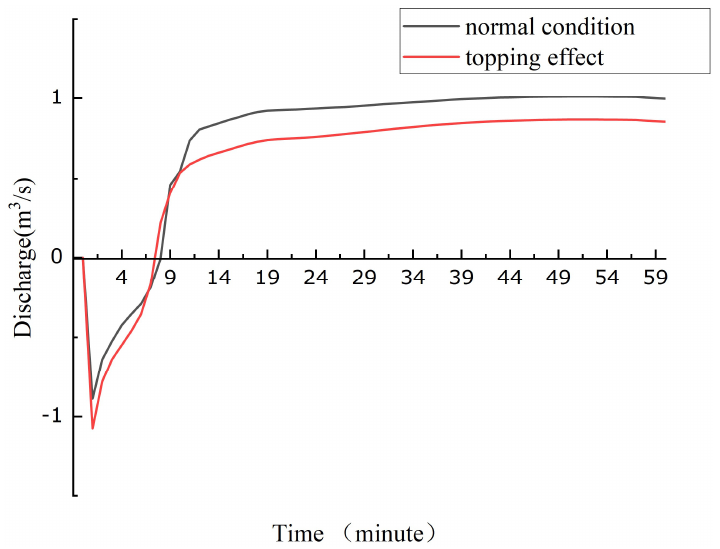
Figure 11. Comparison of discharge flow at the Taiqing Road outfall before and after the water level rises under condition C.